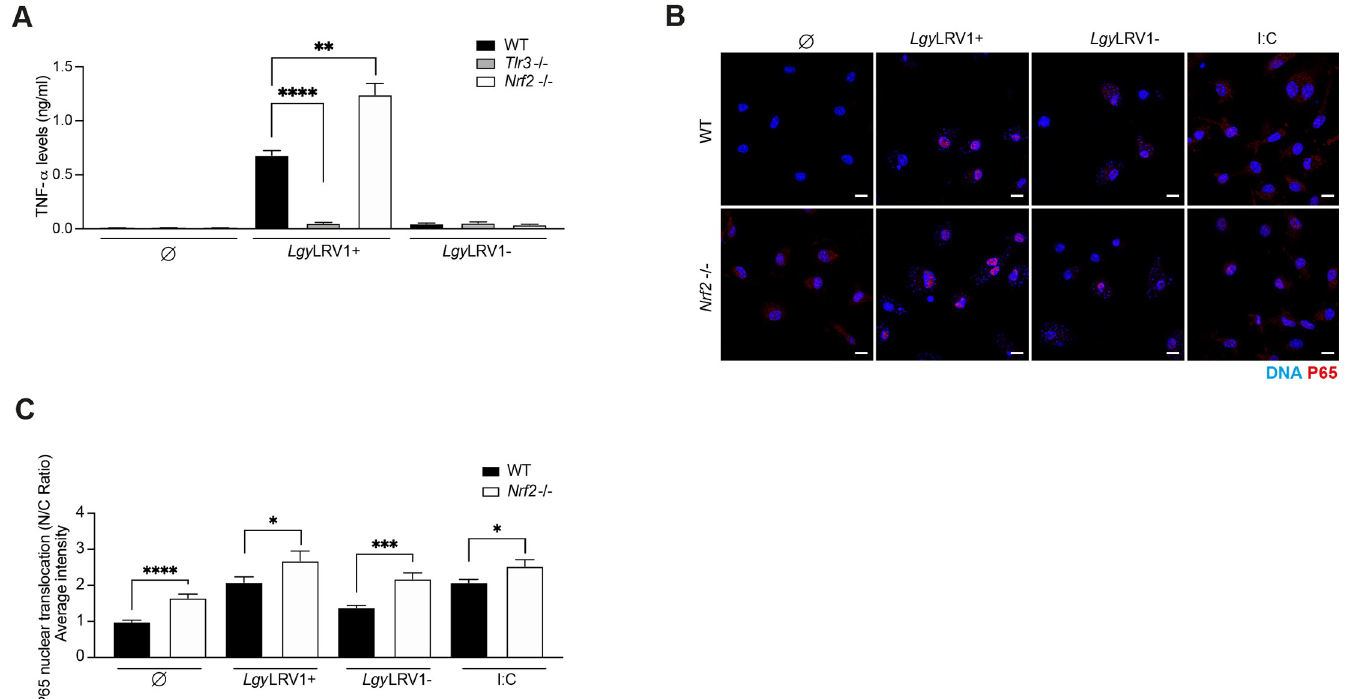
Fig 3. NRF2 expression controls inflammation in Lgy LRV1+ infected macrophages. WT, Tlr3 -/- and Nrf2 -/- , BMDMs were infected with either Lgy LRV1+ or Lgy LRV1- parasites. Negative and positive controls of non-treated ( Ø ), tBHQ (10 μ M), poly I:C (I:C, 2 μ g/ml), TLR3 agonist, were performed concurrently. A) Secreted levels of TNF- α into the supernatant at 24 hr time-point by ELISA. B) Immunofluorescence of nuclear translocation of P65 subunit of NF- κ B complex expressed as nucleus/cytoplasm (N/C) ratio. Cells were stained with NRF2 (red), DNA (blue) at 24 hrs and imaged at 63x using a confocal microscope. Scale bar represents 10 μ m. C) Quantification of P65 nuclear translocation at 24 hrs. P65 nuclear translocation was quantified for each cell (N = 50–90) by IMARIS software. Representative images from two independent experiments are shown. Data show mean ± SEM from a pool of three (A) and two (C) independent experiments. Unpaired Student’s t test was used to assess statistical significance. Not significant (ns), � p < 0.05, �� p < 0.01, ��� p < 0.001, ���� p < 0.0001.